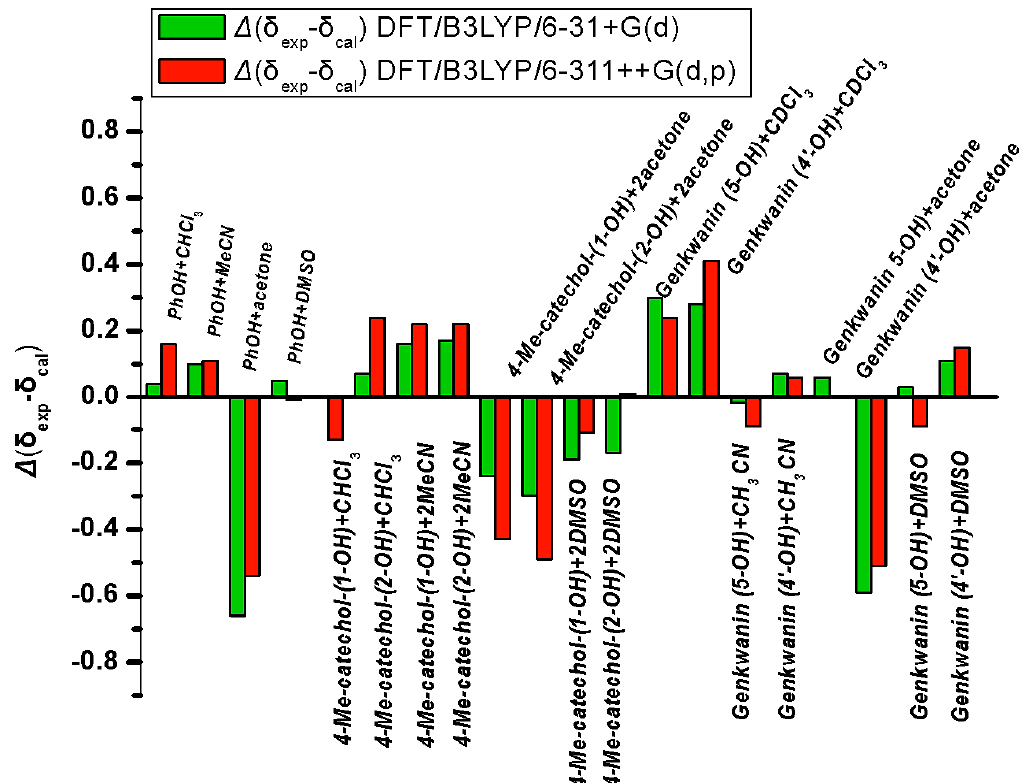
Figure 7. Histogram of the errors ∆ ( δ exp − δ cal ) of the calculated (at the GIAO DFT/B3LYP/ 6-311++G(2d,p) level of theory) 1 H OH chemical shifts with minimization of the complexes with a single solvent molecule at the DFT/B3LYP/6-31+G(d) and DFT/B3LYP/6-311++G(d,p) level of theory. Reprinted, with permission, from [46]. Copyright 2013, The Royal Society of Chemistry.